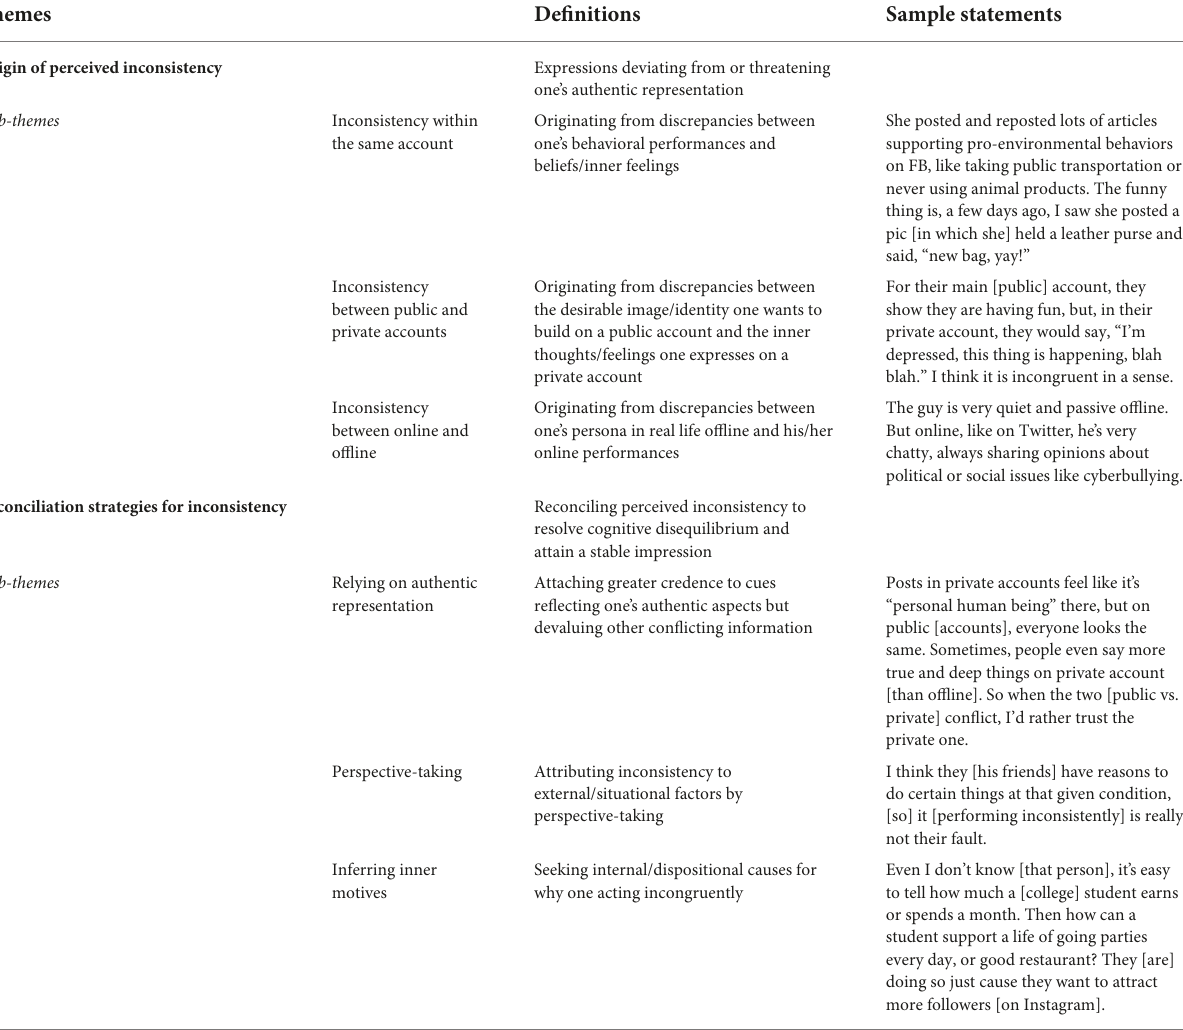
TABLE 1 Summary of research